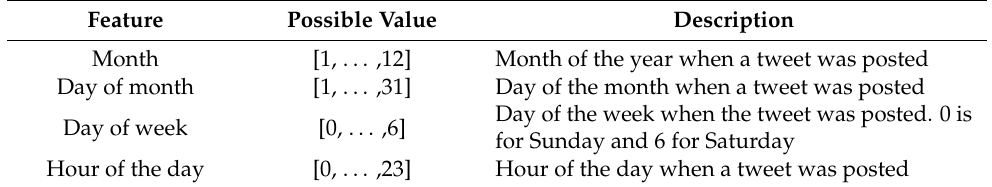
Table 3. Selected features and possible